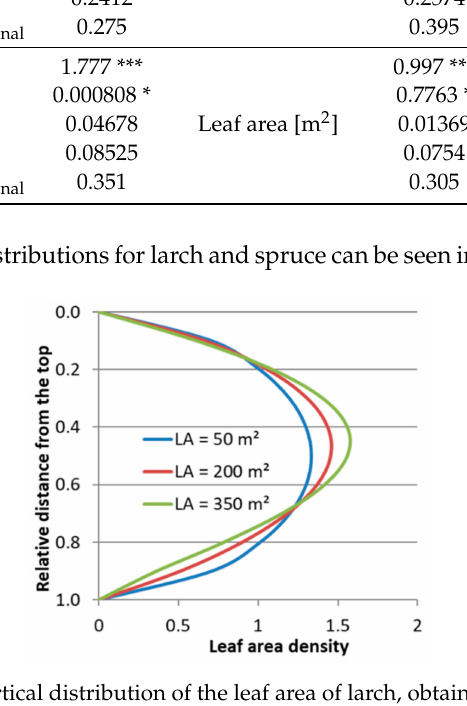
Figure 4. The predicted vertical distribution of the leaf area of larch, obtained by a linear mixed e ff ect model (Equation (11)) with parameter estimates from Table 5, depending on the individual tree leaf area (LA).